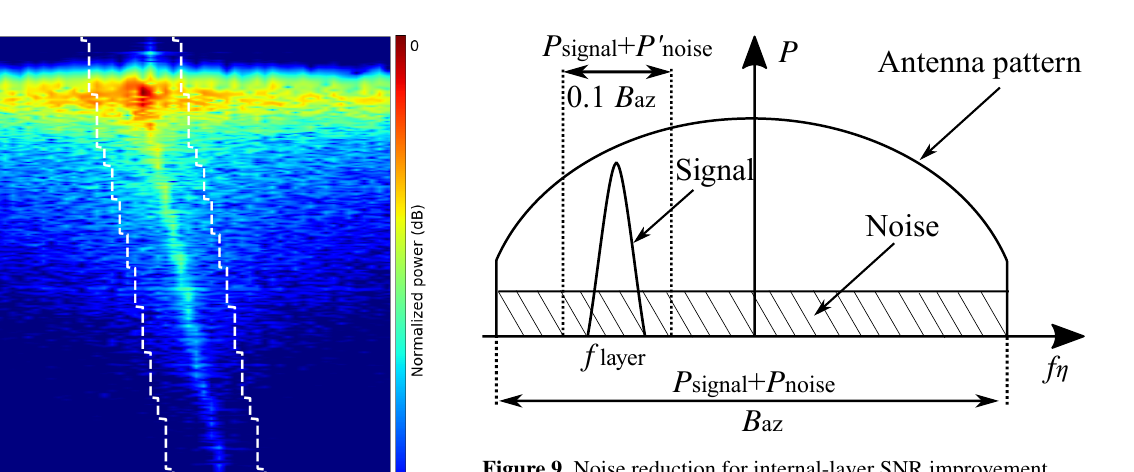
Figure 9. Noise reduction for internal-layer SNR